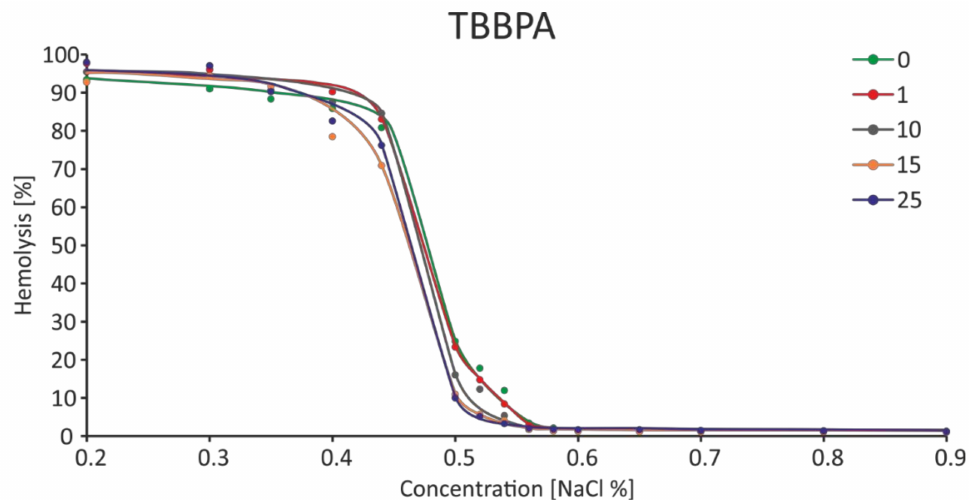
Figure 9. Changes in osmotic resistance of human erythrocytes incubated with TBBPA at 1 to 25 µ g/mL for 3 h.